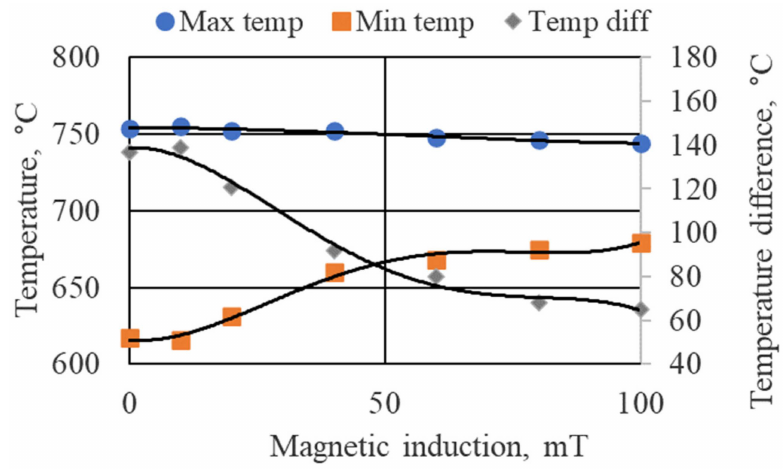
Figure 16. The maximum and minimum temperature and the temperature difference vs. magnetic induction